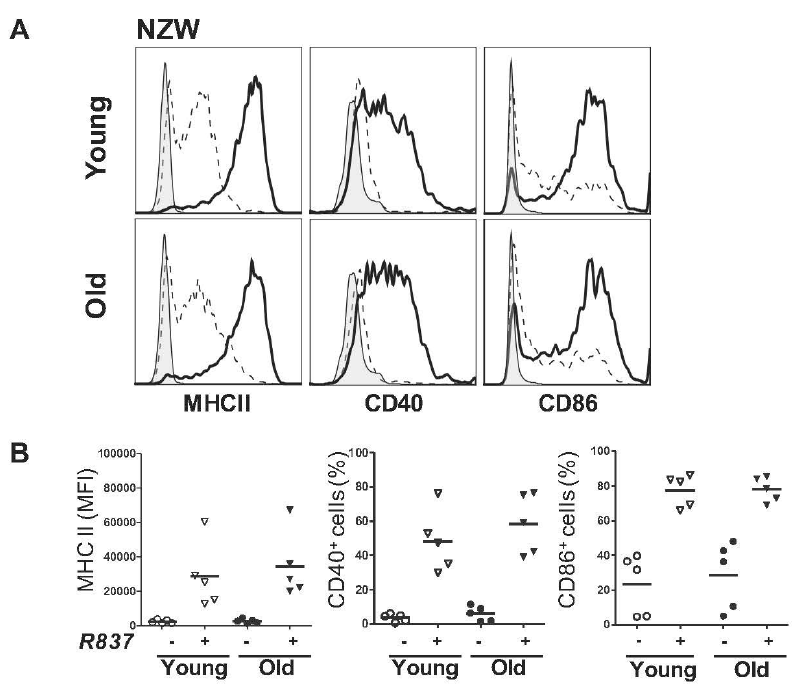
Figure 4. pDCs response to TLR7 stimulation is not affected in young and old NZW mice. Purified BM-derived pDCs from NZW mice age-matched with the pre-symptomatic ( A , shown as Young) and symptomatic ( B , shown as Old) NZB/W NZB/W F1 mice were treated with (+) or without ( − ) 5 µg/mL of R837 for 48 h. Expression of MHC class II, CD40 and CD86 were examined and shown as representative histograms in ( A ). Grey : Isotype; dotted line : unstimulated; solid line : R837 activated. Collective data illustrating changes in the mean fluorescence intensity (MFI) of MHC class II or percentages (%) of CD40 and CD86 are shown in ( B ). Each symbol represents one experimental mouse, n = 5. Data were collected from at least three independent experiments. Bar: mean value.